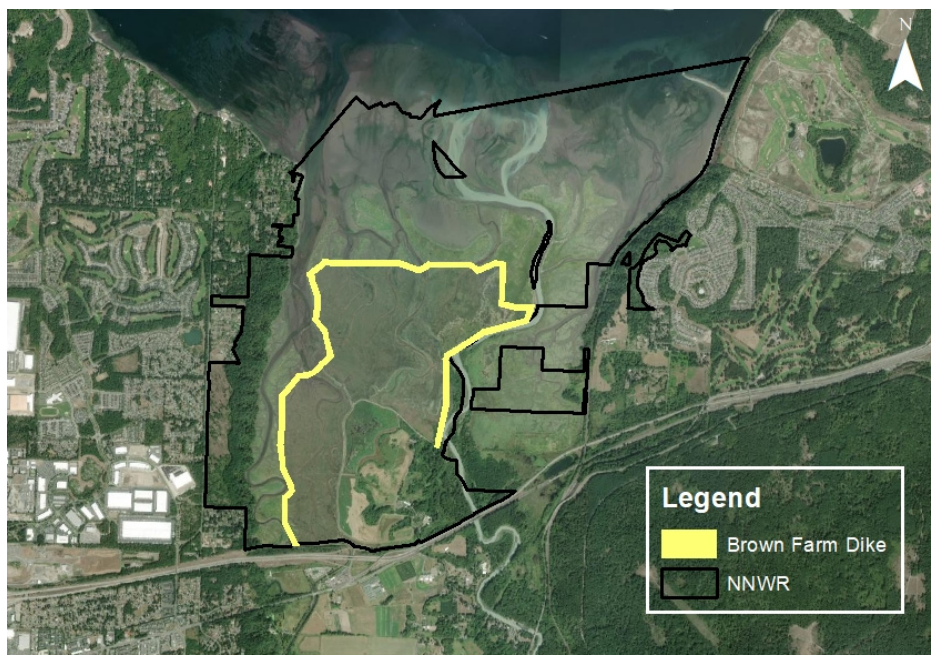
Figure 1. Spatial overview of the Brown Farm Dike and boundary of the Billy Frank Jr. Nisqually National Wildlife Refuge (NNWR).